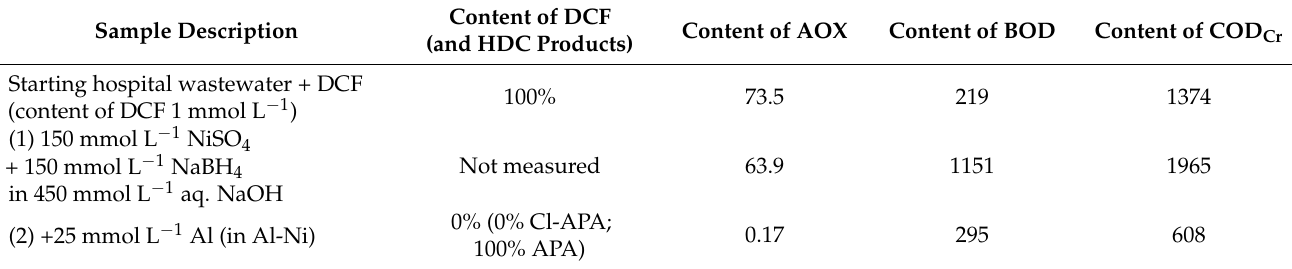
Table 5. Details dealing with the HDC of DCF in hospital wastewater spiked with